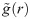
Distribution functions used for calculation of density inhomogeneity.The data shown are obtained from 5 independent simulations for the An-Bn system with total protein concentration c = 6.89×10−5 voxels-1 and reduced temperature T* = 0.383. Error bars indicate standard deviations. (a) Pair distribution functions P(2)(r) and P0(2)(r), where the former is from the interacting system and the latter from the non-interacting system with chain connectivity (prior pair distribution function). Note that P(2)(r) shows two peaks, the first of which indicates dense phase formation. (b) Radial distribution function g˜(r). This captures the droplet formation by a sharp and broad peak in the beginning. The inset shows rb where g˜(r) intersects the line corresponding to g˜(r)=1 line, delineating between the dense and solution phases. The global density inhomogeneity measure, ρ¯, is obtained by integration of absolute deviation of g˜(r) from 1.